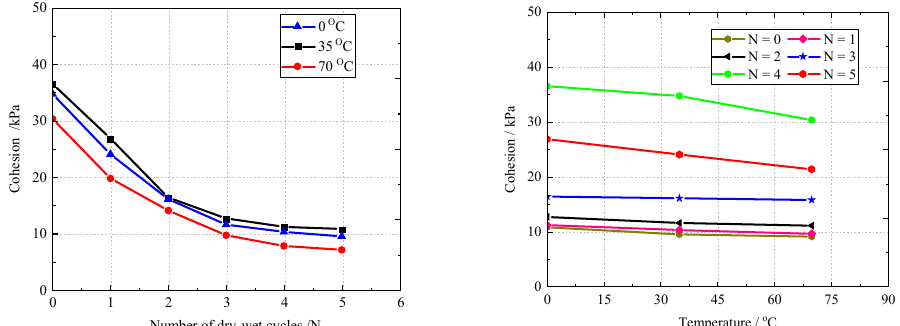
Figure 7. Cohesion curves of soil specimens under dry–wet cycling and temperature.